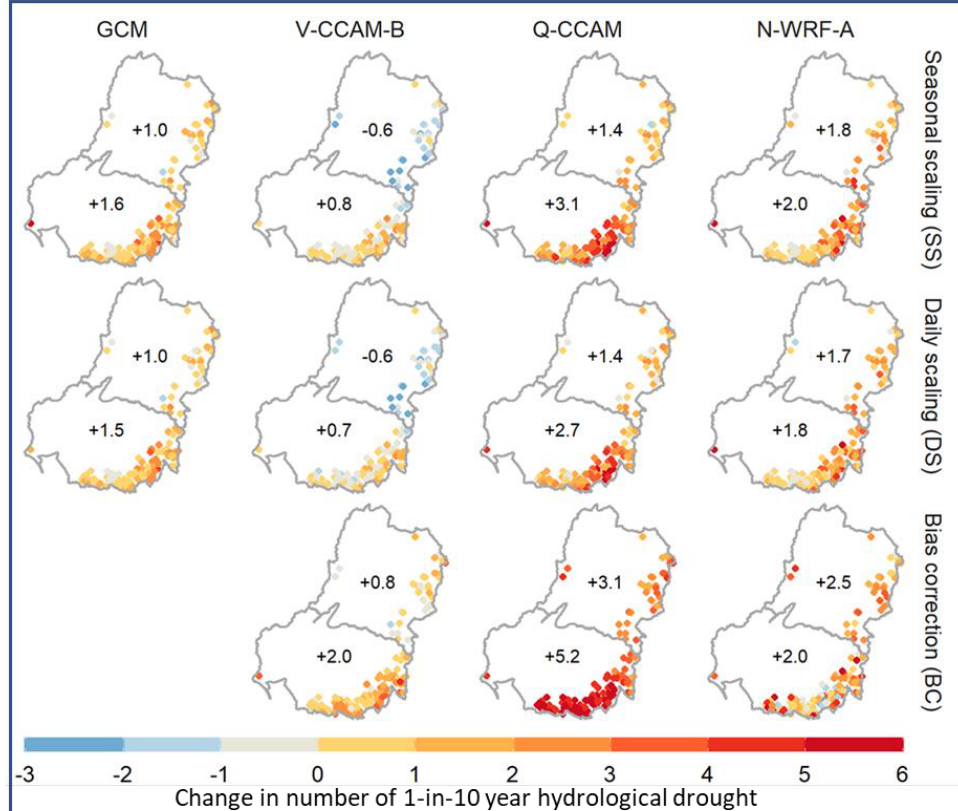
Figure 5. Median value of modelled change in future hydrological drought across the 133 catchments from each of the different climate projection products and methods used to generate future daily rainfall series (numbers in the map show the average of the median values in all the catchments in the northern MDB and the southern MBD).